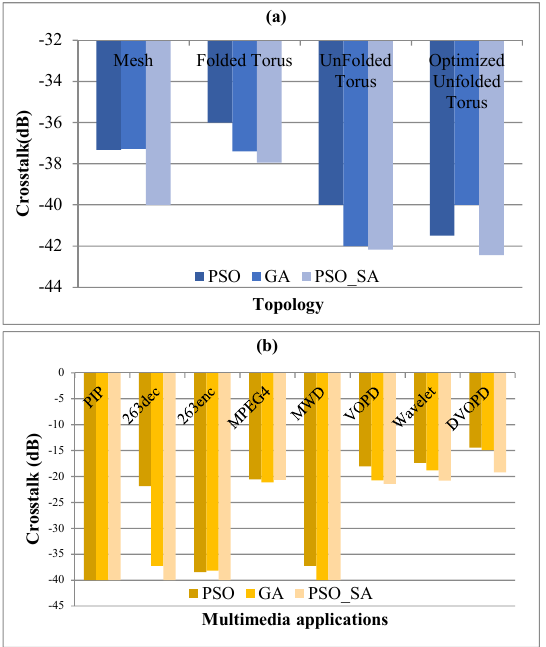
Figure 7. Crosstalk comparison of mapping algorithm. ( a ) crosstalk comparison under different topologies; ( b ) crosstalk comparison under different applications.